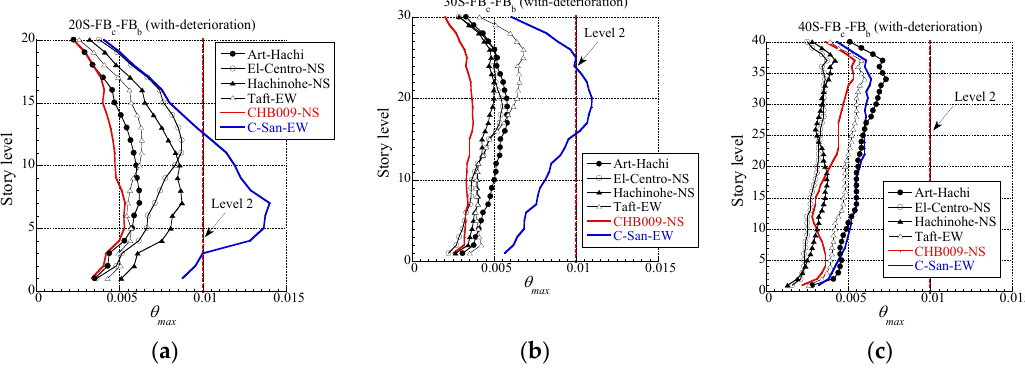
Figure 9. Maximum story drift angle of high ‐ rise SMRFs with thin ‐ walled members under Level 2 earthquakes. ( a ) 20S model; ( b ) 30S model; ( c ) 40S model.